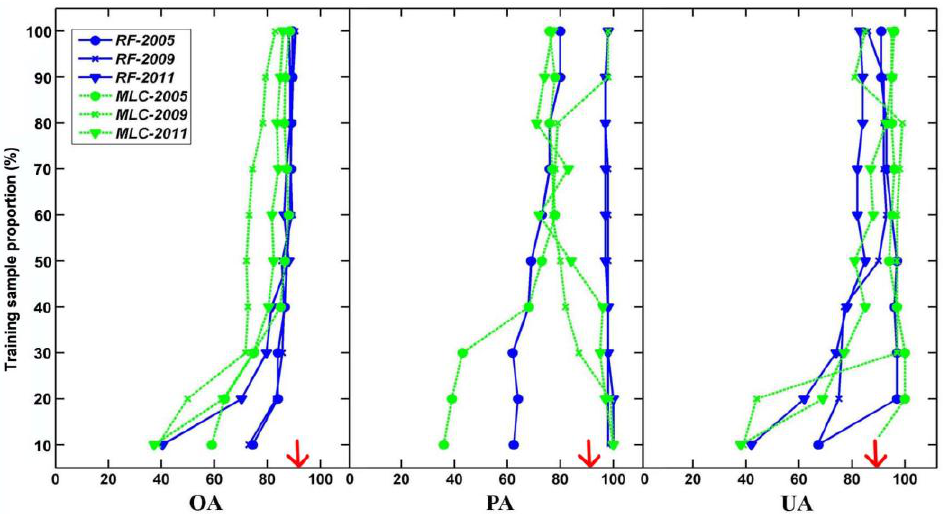
Figure 7. Relationships between accuracy and sample size for the maximum likelihood classifier (MLC) and random forests (RF) using multiple training sets. Graphs arranged from left to right display the trends of overall accuracy, the producer’s accuracy and the user’s accuracy for the mountain pine beetle (MPB) mortality class as the training sample proportion increases from 0.1 to one. Blue and solid lines represent RF results, whereas green and dashed lines represent MLC results. Red arrows indicate the mean accuracies produced by the forest growth trend analysis in the years 2005, 2009 and